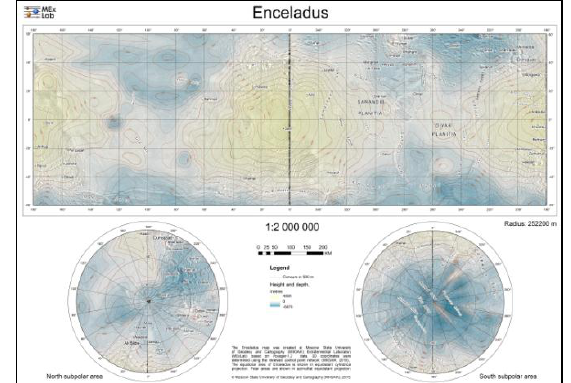
Figure 6. Layout of new global hypsometric map of